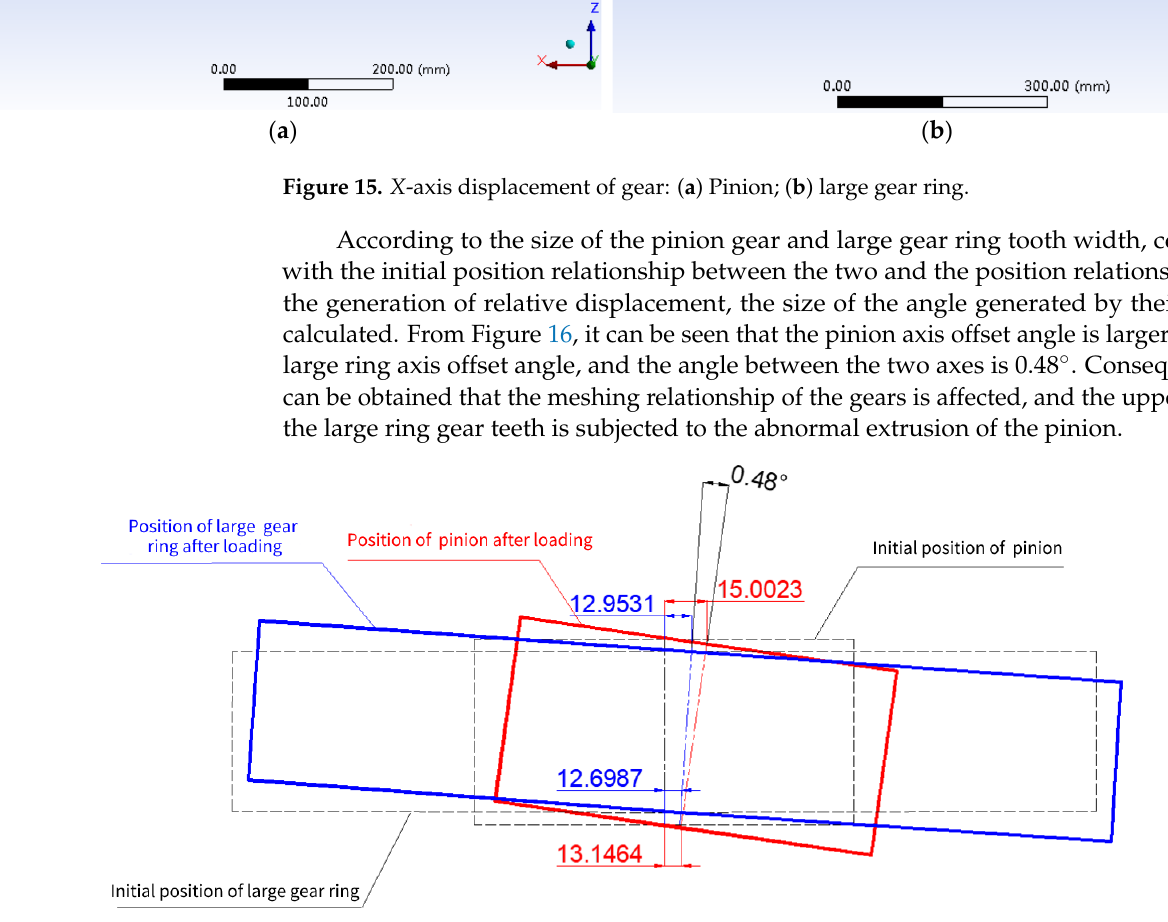
( b ) Figure 17. Stress at the meshing position of the large gear ring: ( a ) Overall stress distribution dia- gram; ( b ) magnified diagram of local stress. Before loading, due to the limitation of the displacement of its roller seat, the pinion and the large ring gear ring of the slewing ring are in a good meshing state, the stress at the root of the slewing ring is uniform, and the load of the gear teeth is ideal. After loading,